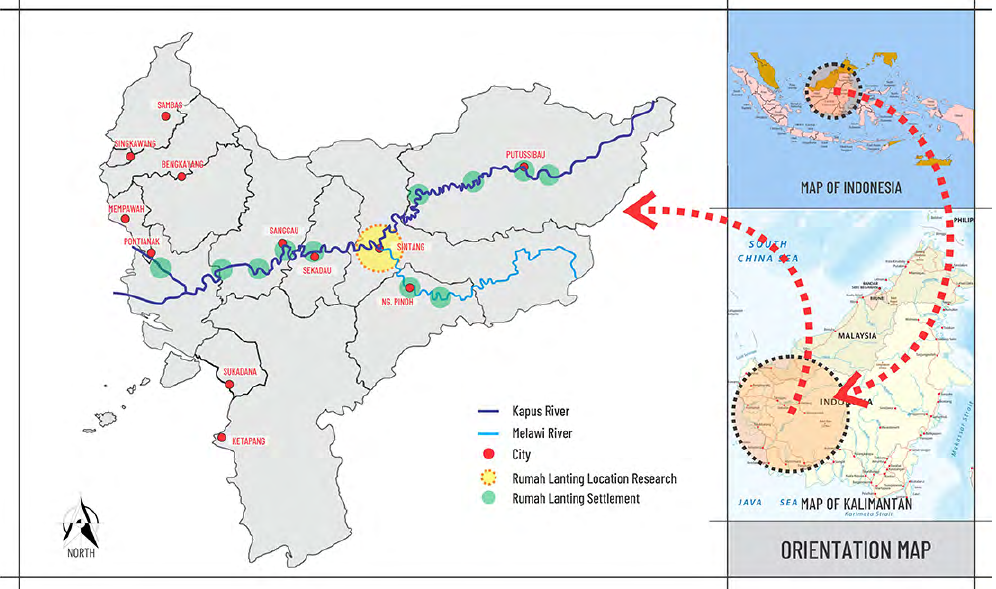
Figure 4. Map of distribution of Rumah Lanting on the Kapuas and Melawi Rivers in West